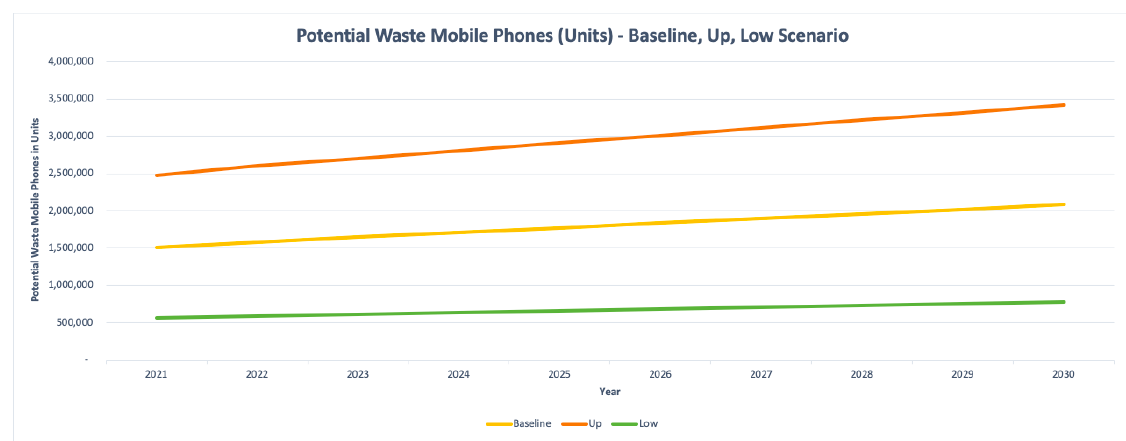
Figure 17. Waste mobile phones — baseline, up, and low scenarios (units).